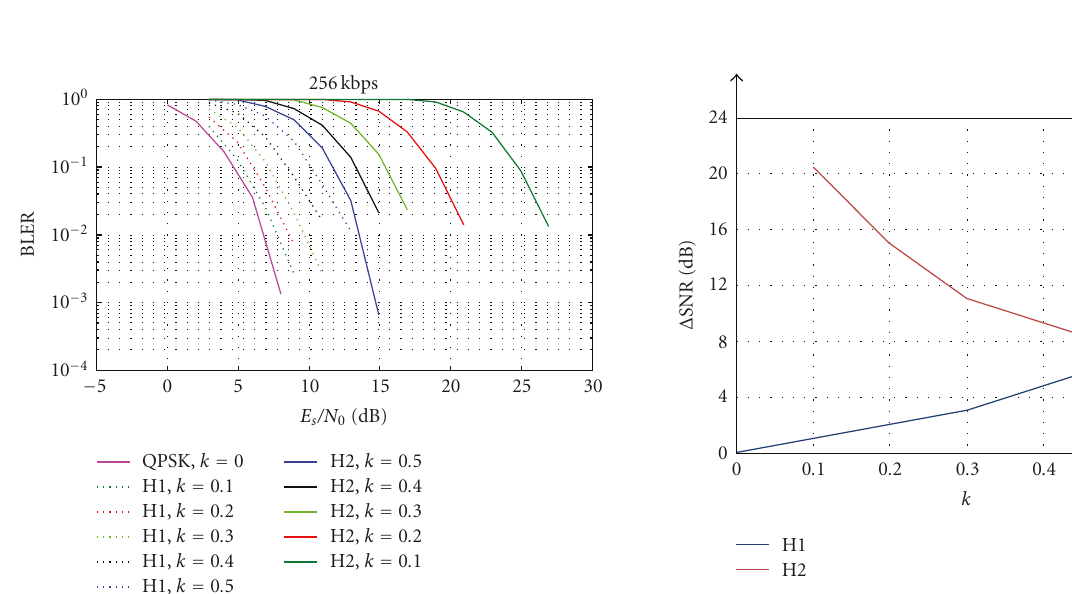
Figure 9: Δ SNR versus k for hierarchical 16-QAM, 256 kbps, VehA